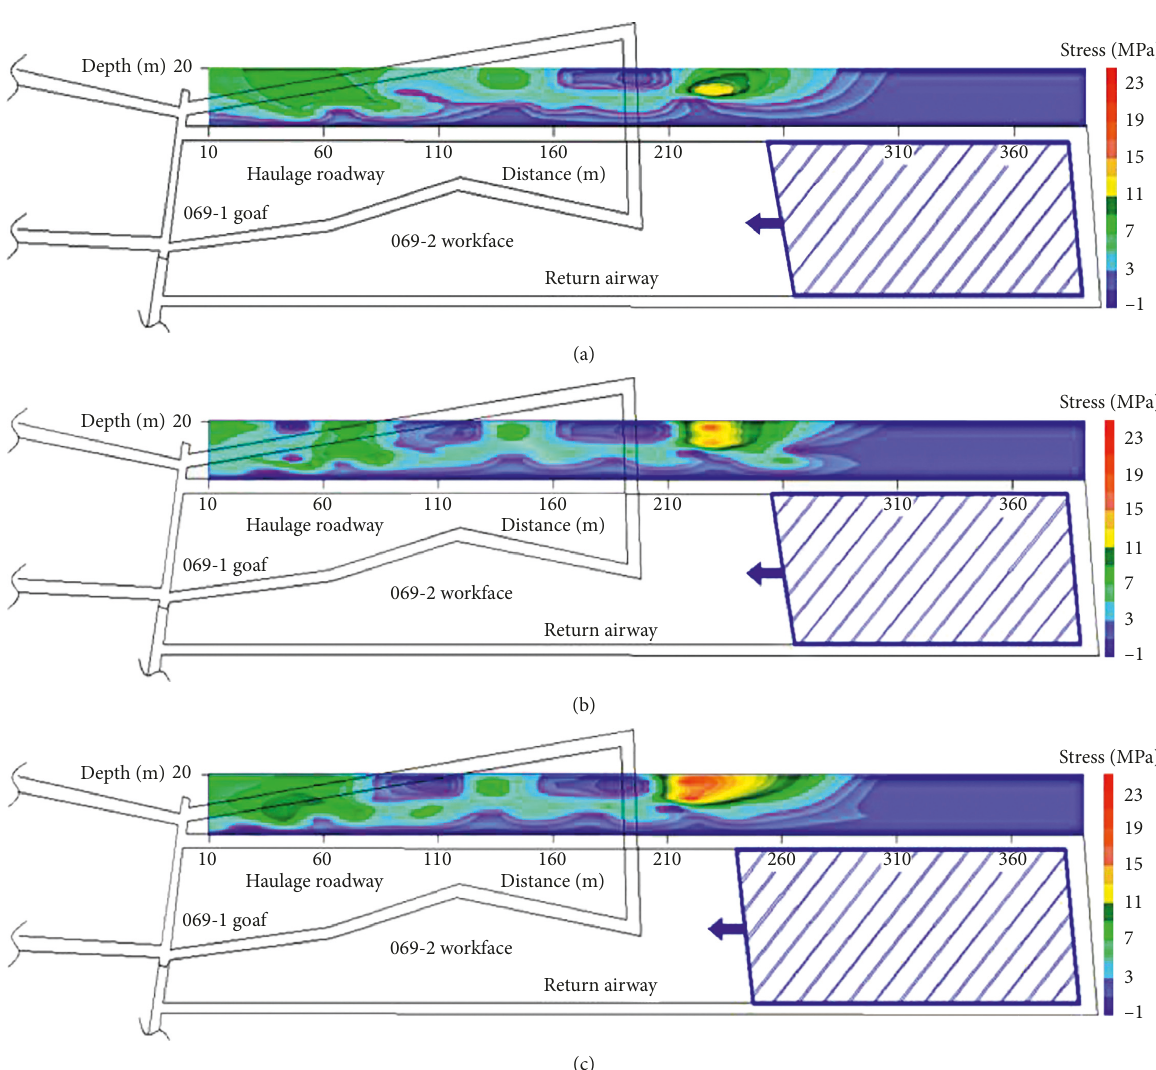
Figure 9: Stress nephogram of low sidewall in haulage roadway of coal mining face with different pushing rate. (a) Coal mining face pushed at 125m. (b) Coal mining face pushed at 137m. (c) Coal mining face pushed at 154m.